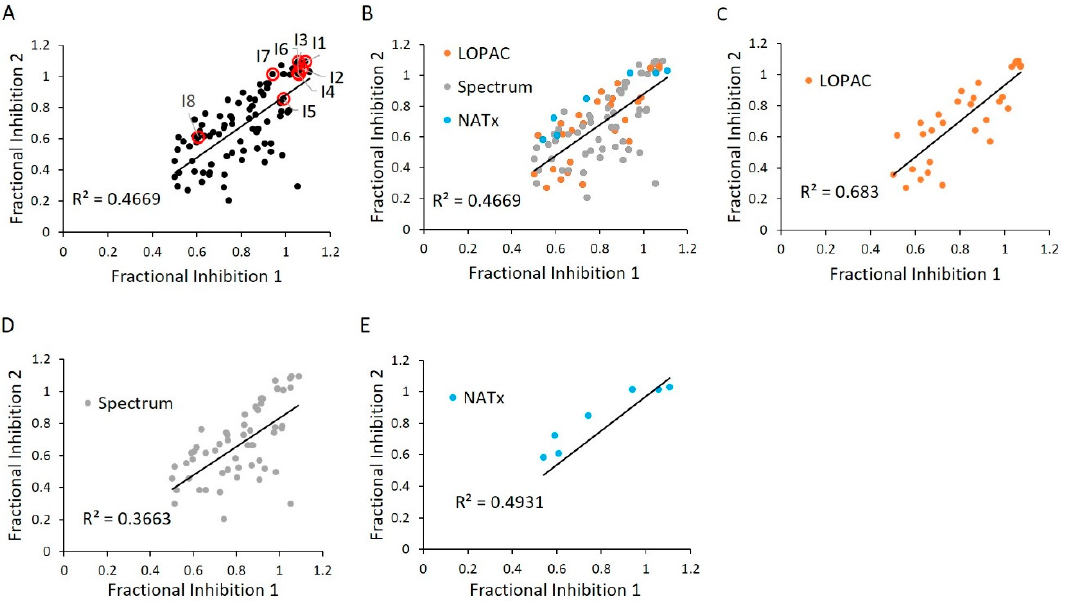
Figure 11. E234G HYPE inhibitor validation. ( A ) Comparison between initial HTS compound activity ( x -axis) and second-pass validation ( y -axis) with the same FP AMPylation assay. All validation compounds were assayed on the same plate and normalized to internal positive (E234G HYPE) and negative (WT HYPE) DMSO controls. Each dot represents the same compound incubated in two independent AMPylation reactions. Dots with red circles show hits selected for follow-up, orthogonal validation. ( B – E ) Data reprocessed from ( A ) to show compound validation among the various libraries.